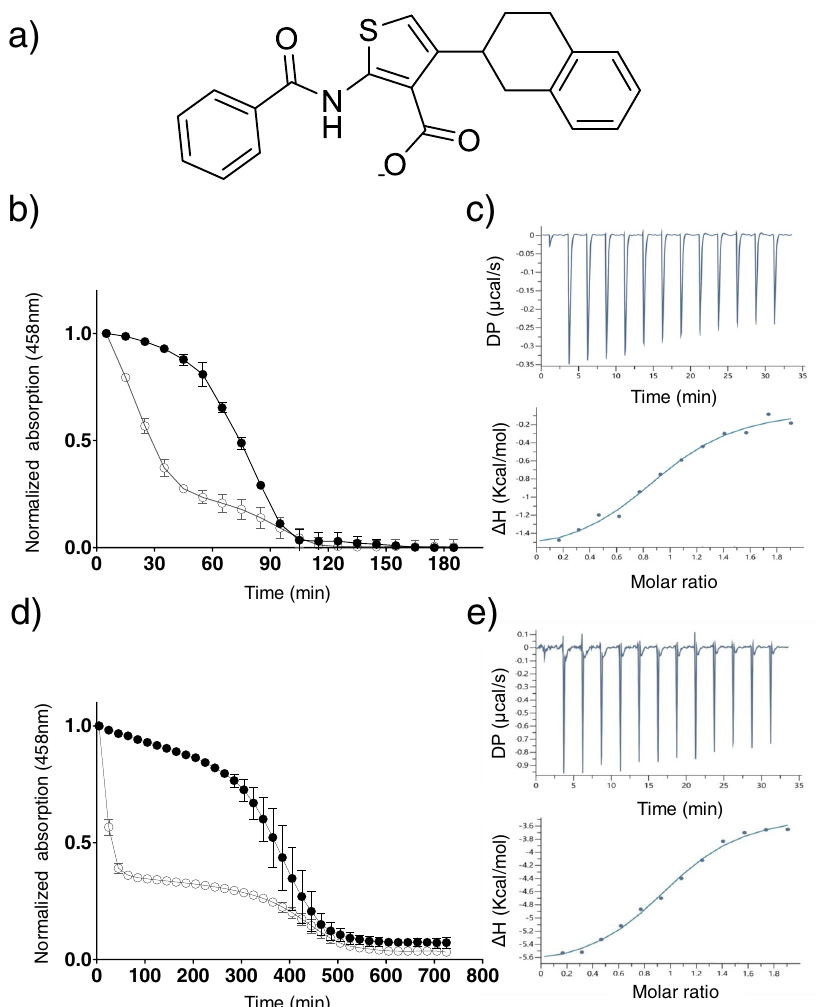
Fig. 1 M1 enhances the lability of mNT and NAF-1 ’ s [2Fe – 2S] clusters. a Structure of the M1 molecule. The [2Fe-2S] cluster-release from 20 µ M of mNT ( b ) or 20 µ M NAF-1 ( d ) NEET proteins was monitored by UV-Vis absorption spectroscopy. The 458 nm characteristic absorption peak of [2Fe – 2S] clusters of the NEET proteins which were incubated with- (empty circle) or without ( fi lled circle) 60 µ M of M1 molecule, at a temperature of 37 °C and pH 6.0. Error bar represents the standard deviation of three independent experiments. ITC binding curve of M1 to mNT ( c ) or to NAF-1, ( e ). 50 µ M of proteins (mNT or NAF-1) were titrated against 500 µ M of M1 by injecting 3 µ L for 13 injections. Each measurement was repeated in three independent